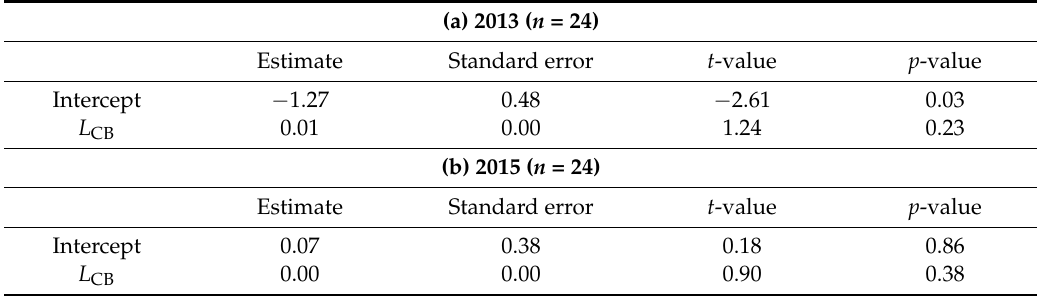
Table 2. The regression between relative photosynthetic photon flux density (ln(rPPFD)) and the length between the crown base and the base of primary branch ( L CB ) in ( a ) 2013 and ( b ) 2015. The data of rPPFD (%; the response variable) were log-transformed to meet the assumption of normal residuals.